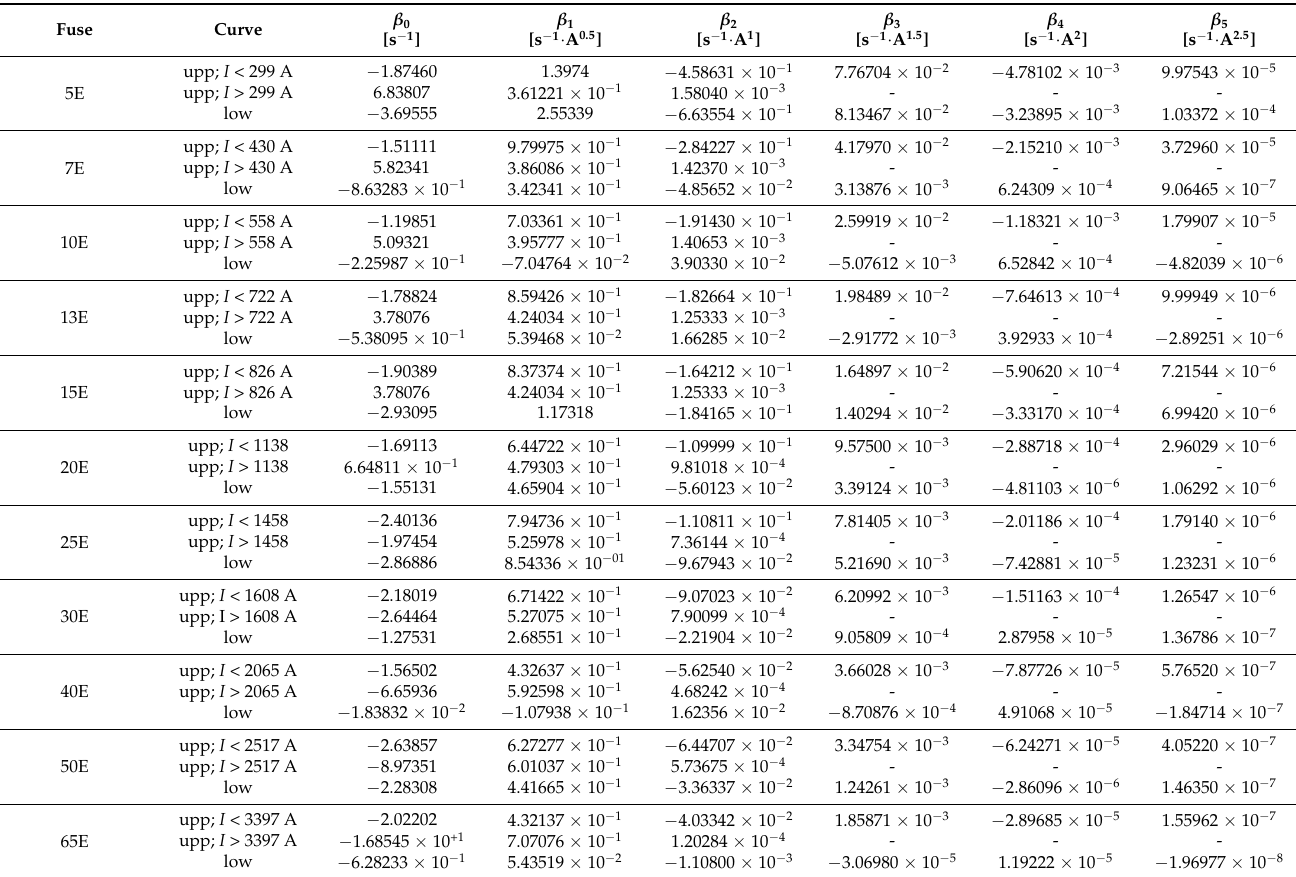
Table 5. Coefficients of Equations (6) and (7) fitted to the upper (upp) and lower (low) tripping time curves, t ES and t EI , of different S&C Electric Company SMD-50 fuses. See also Figures 4 and 5. Fuse